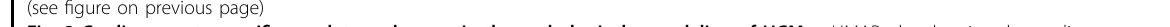
Fig. 2 Cardiomyocyte-speci fi c regulatory changes in the pathological remodeling of HCM. a UMAP plot showing the cardiomyocyte subpopulations. b Heatmap showing the molecular signatures of each subpopulation. c Relative proportion of each subpopulation in the cardiomyocytes from each condition. + : expansion; – : contraction. d Immuno fl uorescence staining con fi rmed the presence of the subpopulations in cardiac tissues from HCM patients. Cardiomyocytes are marked by Actin. BNP is encoded by the gene NPPB . Scale bar: 10 μ m. e Representative terms enriched in the signi fi cantly upregulated genes in cardiomyocytes from HCM patients compared with those from healthy donors. Adjusted P - value < 0.05, hypergeometric test. f Cellular trajectory reconstructed for the transition towards failing cardiomyocytes using Slingshot. The arrow shows the direction of cellular state changes. g Density curves showing the distributions of the two subpopulations along the trajectory. h Density curves showing the distributions of the cardiomyocytes from two different conditions along the trajectory. ** P -value < 2.2e-16, Kolmogorov – Smirnov test. i Heatmaps showing the expression dynamics of the 216 genes with signi fi cantly different patterns along the trajectory between the two conditions. These genes were detected by differential expression pattern analysis using the “ conditionTest ” function of tradeSeq and were categorized into 7 gene clusters by hierarchical clustering. The signi fi cance threshold was set to be adjusted P -value < 0.05. j The potential key genes that were prioritized based on the results of three independent analyses including the difference in expression patterns, the fold change of expression levels, and the centrality change in GRNs. DRN rank: the gene ranking based on the centrality change in GRNs obtained by differential regulatory network analysis. Log2FC: log2 fold change of the expression levels in cardiomyocytes. Wald stat: the natural logarithm of the statistics of differential expression pattern analysis. Only genes encoding TFs, ligands, and receptors were considered. k Smoothed expression curves of representative candidate genes along the trajectory under both conditions. l Western blot assays con fi rmed that the protein levels of FGF12 and BNP were signi fi cantly changed in cardiac tissues from HCM patients ( n = 5) compared with those from healthy donors ( n = 5). ** P < 0.01, Wilcoxon ra n k-sum